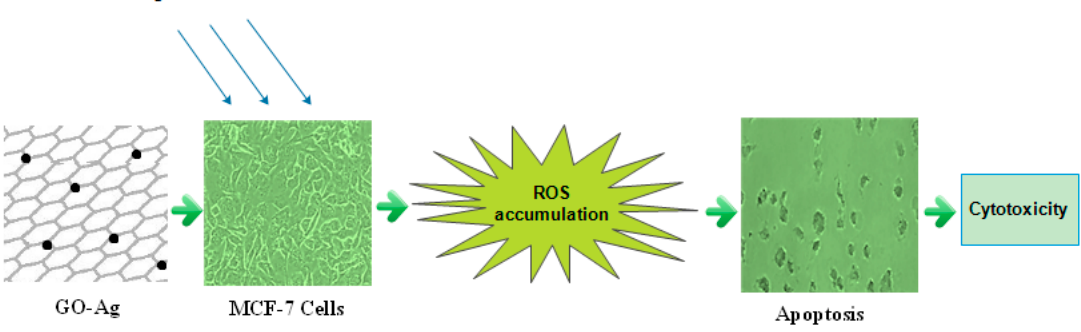
Figure 13. Schematic diagram represented the ROS accumulation by GO-Ag under light irradiation of 430 nm.